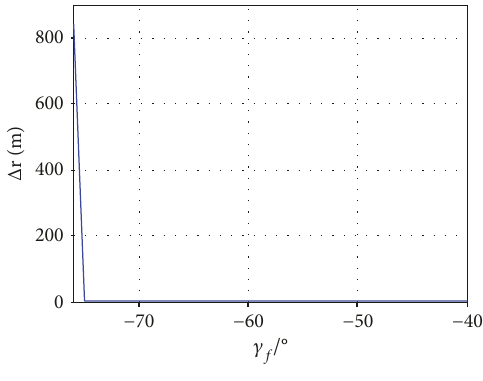
Figure 7: Curve of dropping error with γ